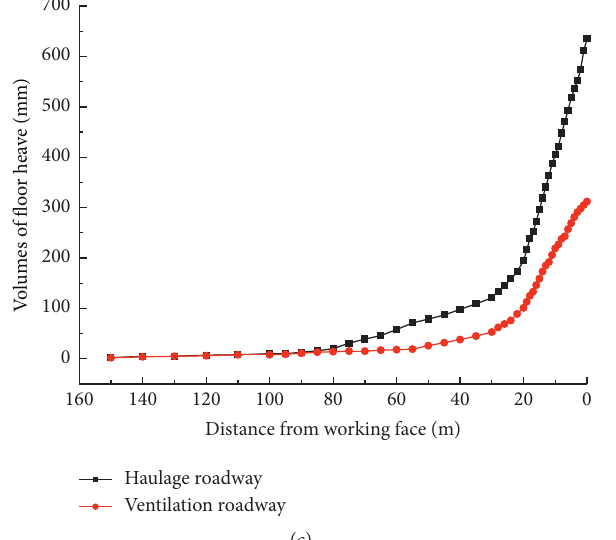
Figure 11: The on-site monitoring curves. (a) On-site monitoring curves of roof subsidence. (b) On-site monitoring curves of ribs displacement. (c) On-site monitoring curves of floor